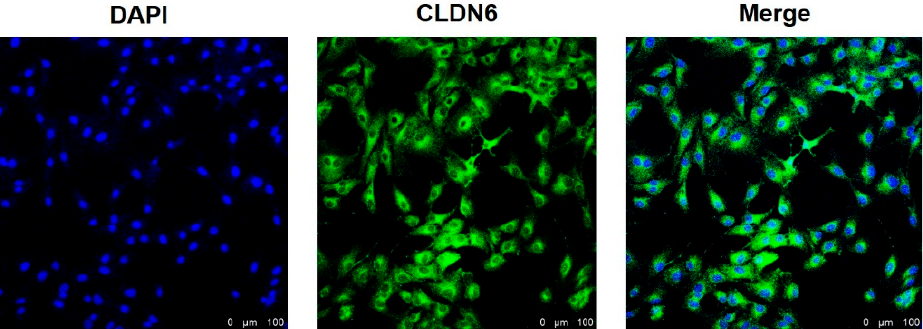
Figure 2. CLDN6 protein in bovine CCs was localized by immunofluorescence staining. The nuclei of CCs were stained with DAPI and viewed under ultraviolet fluorescence. CLDN6 was labeled with Alexa Fluor 488 and viewed under blue fluorescence. Bar = 100 µm.